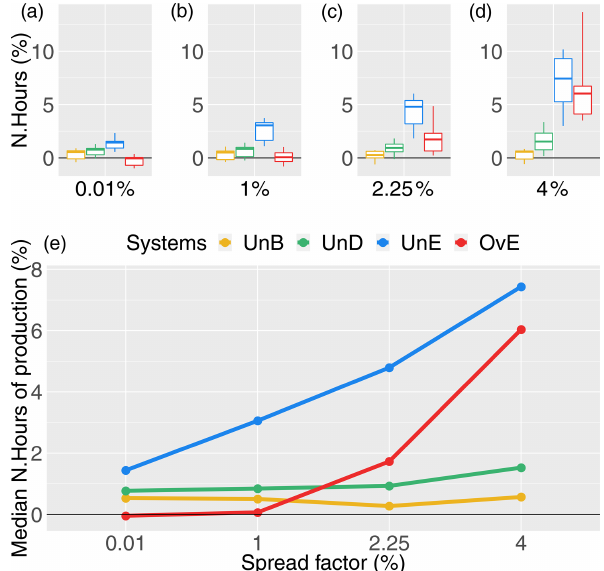
Figure 9. Total production of the synthetic ensemble forecasting systems as a percentage of the total production of the reference system (i.e., the “perfect system”, where forecasts are equal to ob- servations): unbiased system (UnB, yellow), underdispersed system (UnD, green), underestimating system (UnE, blue) and overestimat- ing system (OvE, red). Systems are based on ensembles generated with four different spread factors (0.01%, 1%, 2.25% and 4%). (a–d) Boxplots represent the maximum value, percentiles 75, 50 and 25, and minimum value over the 10 studied catchments. (e) Me- dian value.